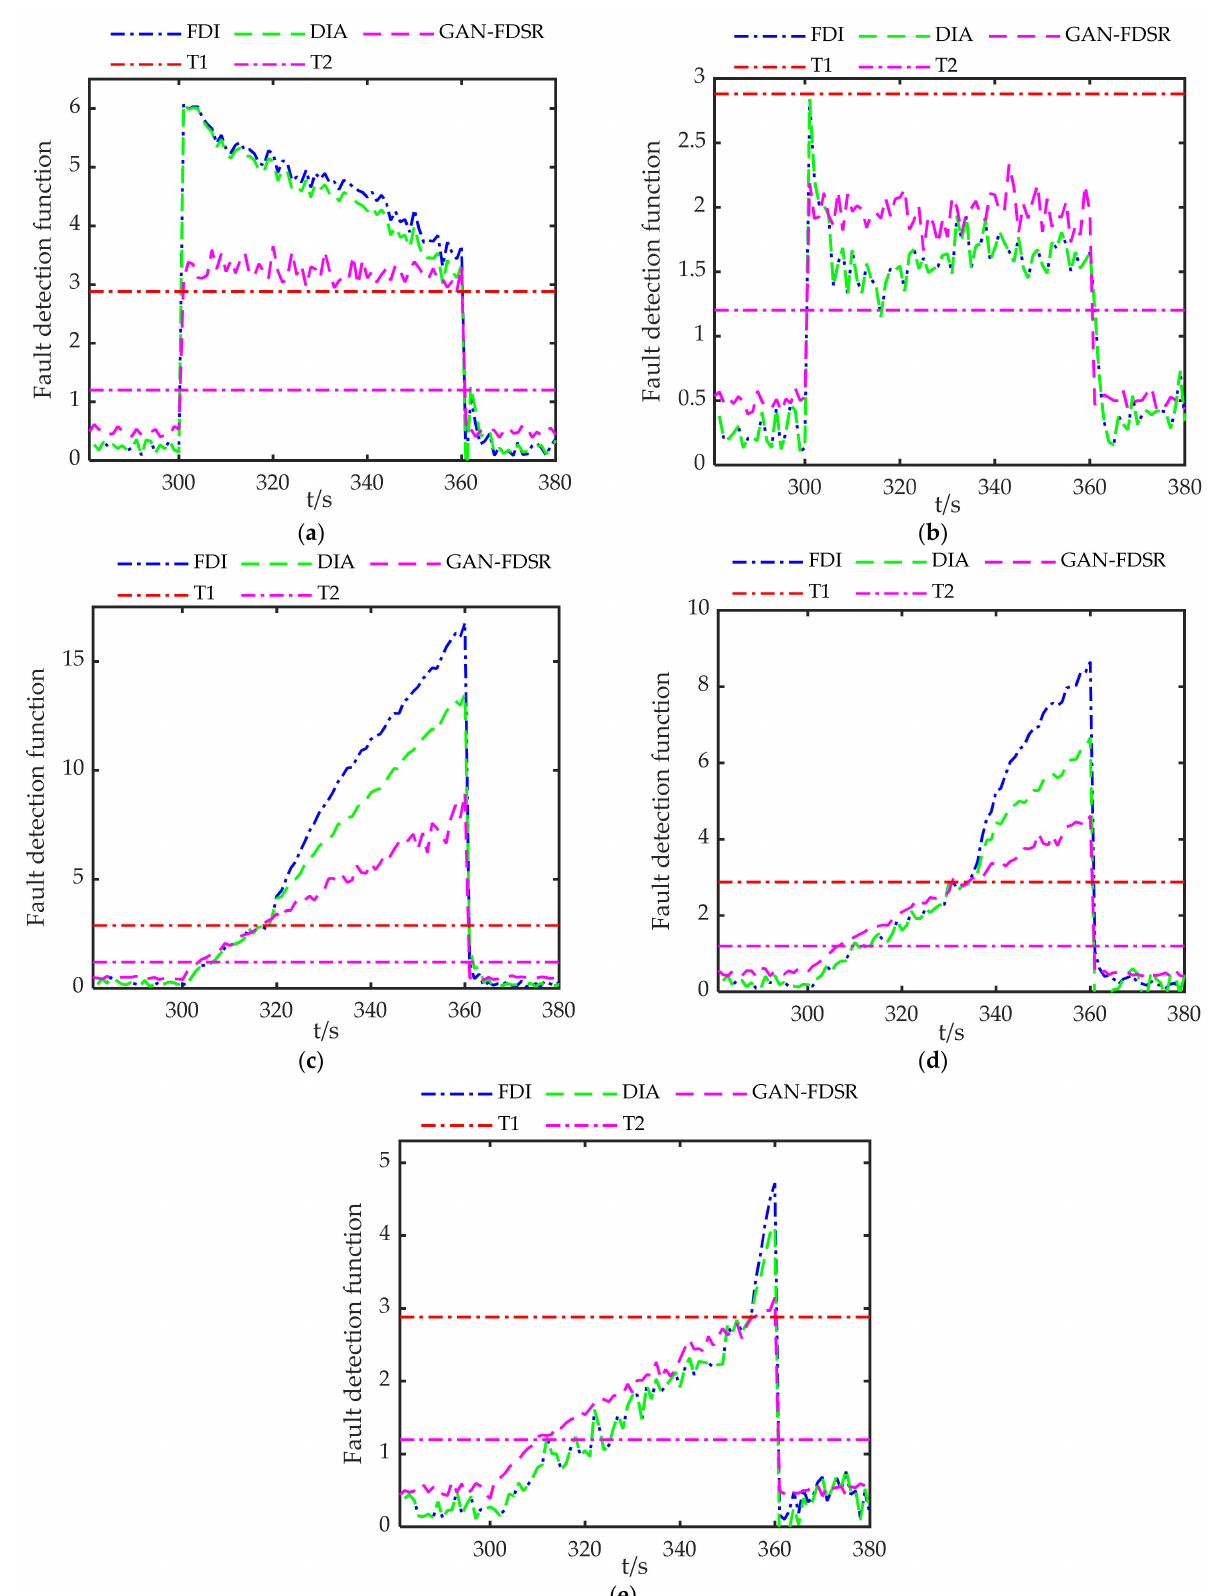
Figure 10. Fault detection functions for three methods: ( a – e ) show the fault detection functions under Type 1, Type 2, Type 3, Type 4 and Type 5 faults,